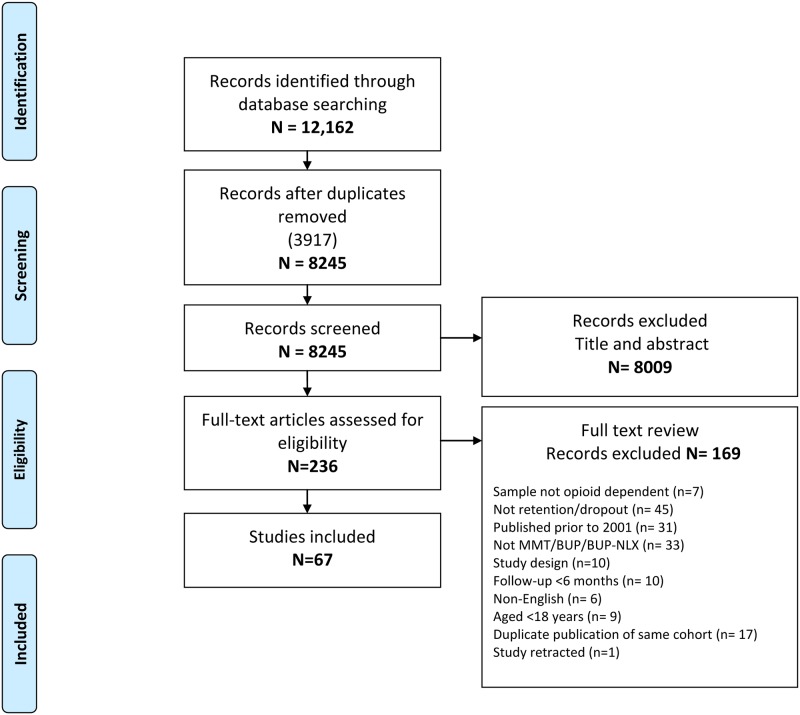
PRISMA flowchart.